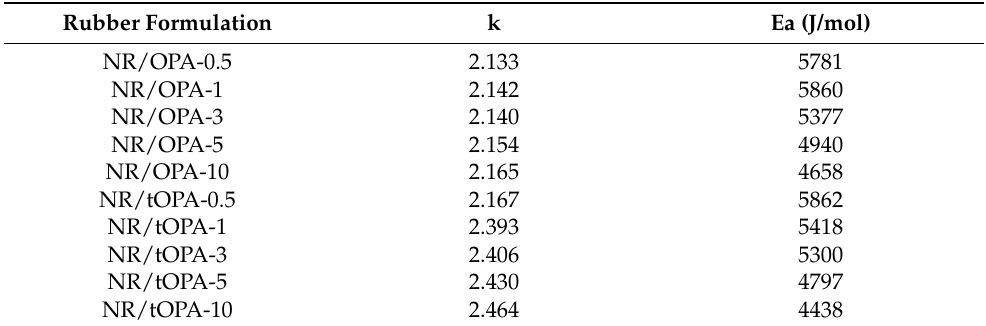
Figure 11. Plot ln[1 − α ] versus time of ( a ) NR/OPA and ( b ) NR/tOPA at different loading in vulcanizing stage. Table 8. Rate of vulcanization (k) and activation energies (Ea) of NR/OPA and NR/tOPA with the different